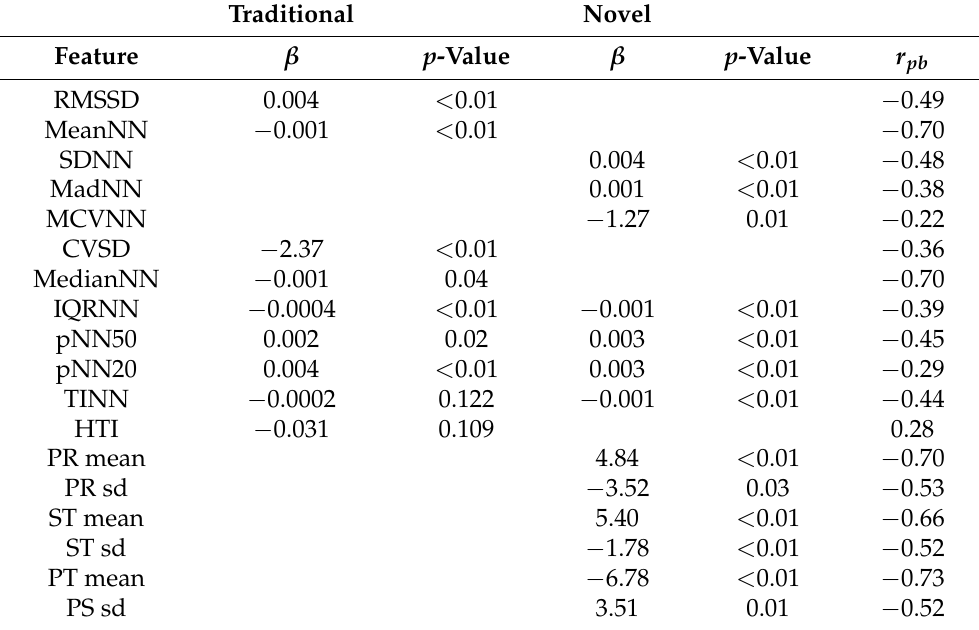
Table 2. Coefficients, p -values, and validity coefficients for each feature as they are included in both the traditional and novel models. All validity coefficient values had p -values < 0.01. The TFM includes 9 traditional R peak features, and the NFM includes 7 traditional R peak features and 6 novel small peak features for a total of 13 features. There is overlap between the two models in four of the traditional features: IQRNN, pNN50, pNN20, and